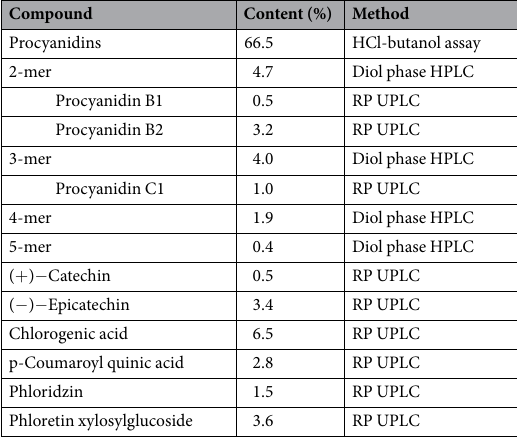
Table 1. Components of polyphenols contained in apple polyphenols. The total procyanidins and procyanidin oligomers were measured by HCl-butanol assay and diol phase HPLC, respectively. The quantity of each component was analyzed by reversed phase (RP) UPLC individually.